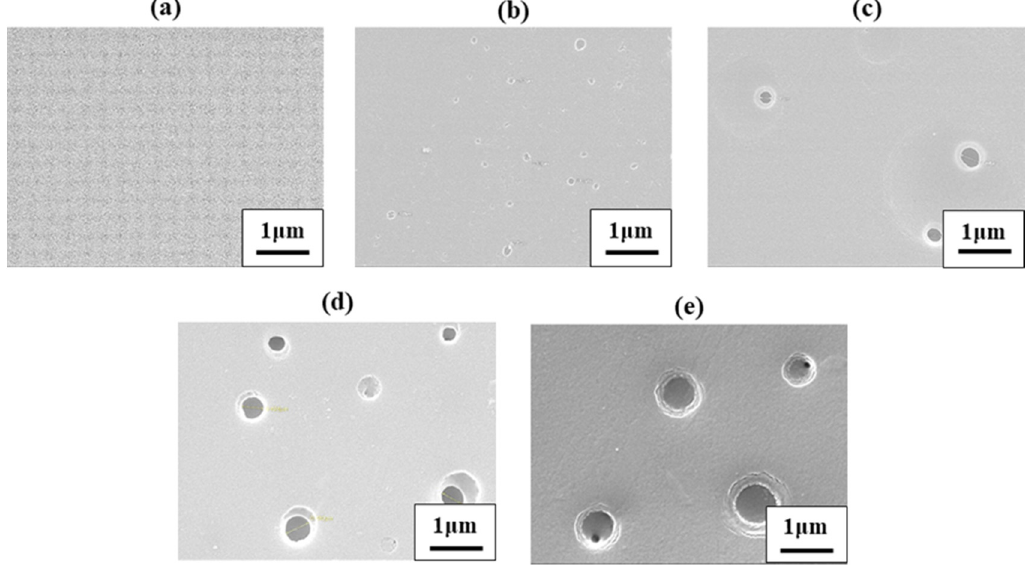
Figure 6. SEM images of micropores in CPI membrane films with 6FAm containing ( a ) 0, ( b ) 0.5, ( c ) 1.0, ( d ) 2.0, and ( e ) 5.0 wt% PVA.